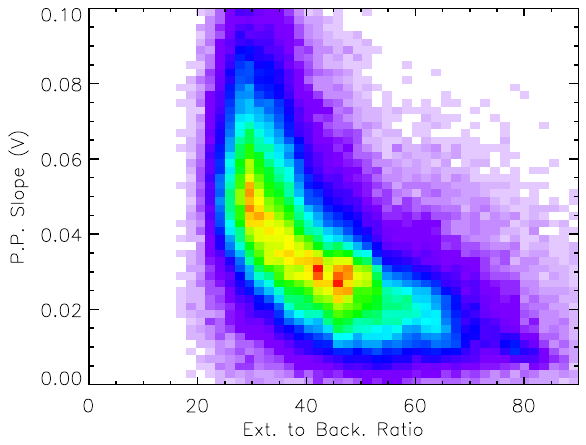
Fig. 6. Two-dimensional histogram of the retrieved EBR ( x axis) and phase function slope at backscatter as shown in Figs. 4 and